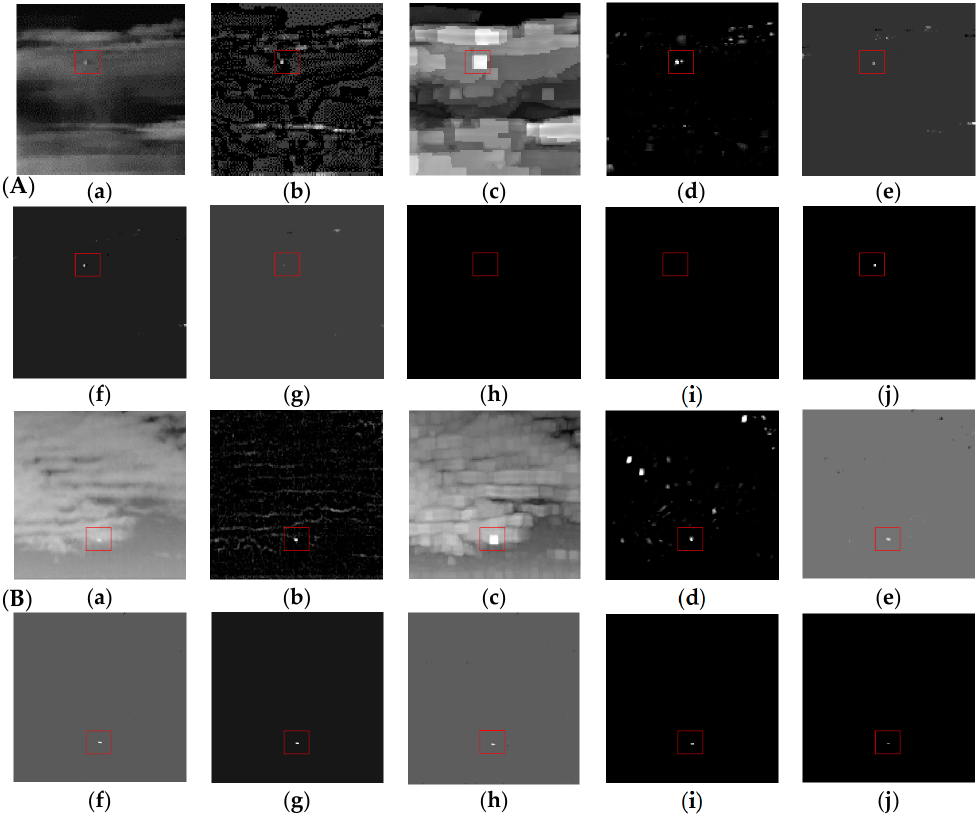
Figure 7. Results of the different approaches to Scenes 1 and 2. ( A ) Scene 1 (Sequence 1); ( B ) Scene 2